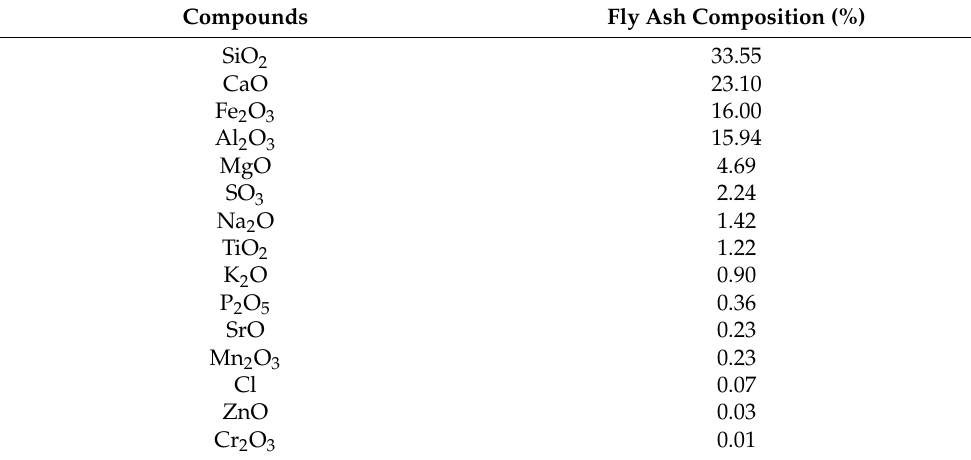
The FTIR spectra of the CS/PEO, CS/PEO/NaClO 4 , and CS/PEO/NaClO 4 /fly ash SPE are shown in Figure 3. FTIR analysis of the SPE was used to determine the interactions between CS, PEO, NaClO 4 , and fly ash. The broad peak at a wavenumber of 3538 cm − 1 was due to O-H group vibration. The vibrations of CH 2 occurred at wavenumbers 2884, 1464, 1402, 1341, 1360, 1282, and 1237 cm − 1 . The absorption band of C=O-NHR was observed at a wavenumber of 1640 cm − 1 and the absorption band of amine-NH 2 was observed at 1543 cm − 1 . The stretching vibrations of the C-O-C bonds appeared at the peaks of 1144, 1095, and 1058 cm − 1 .